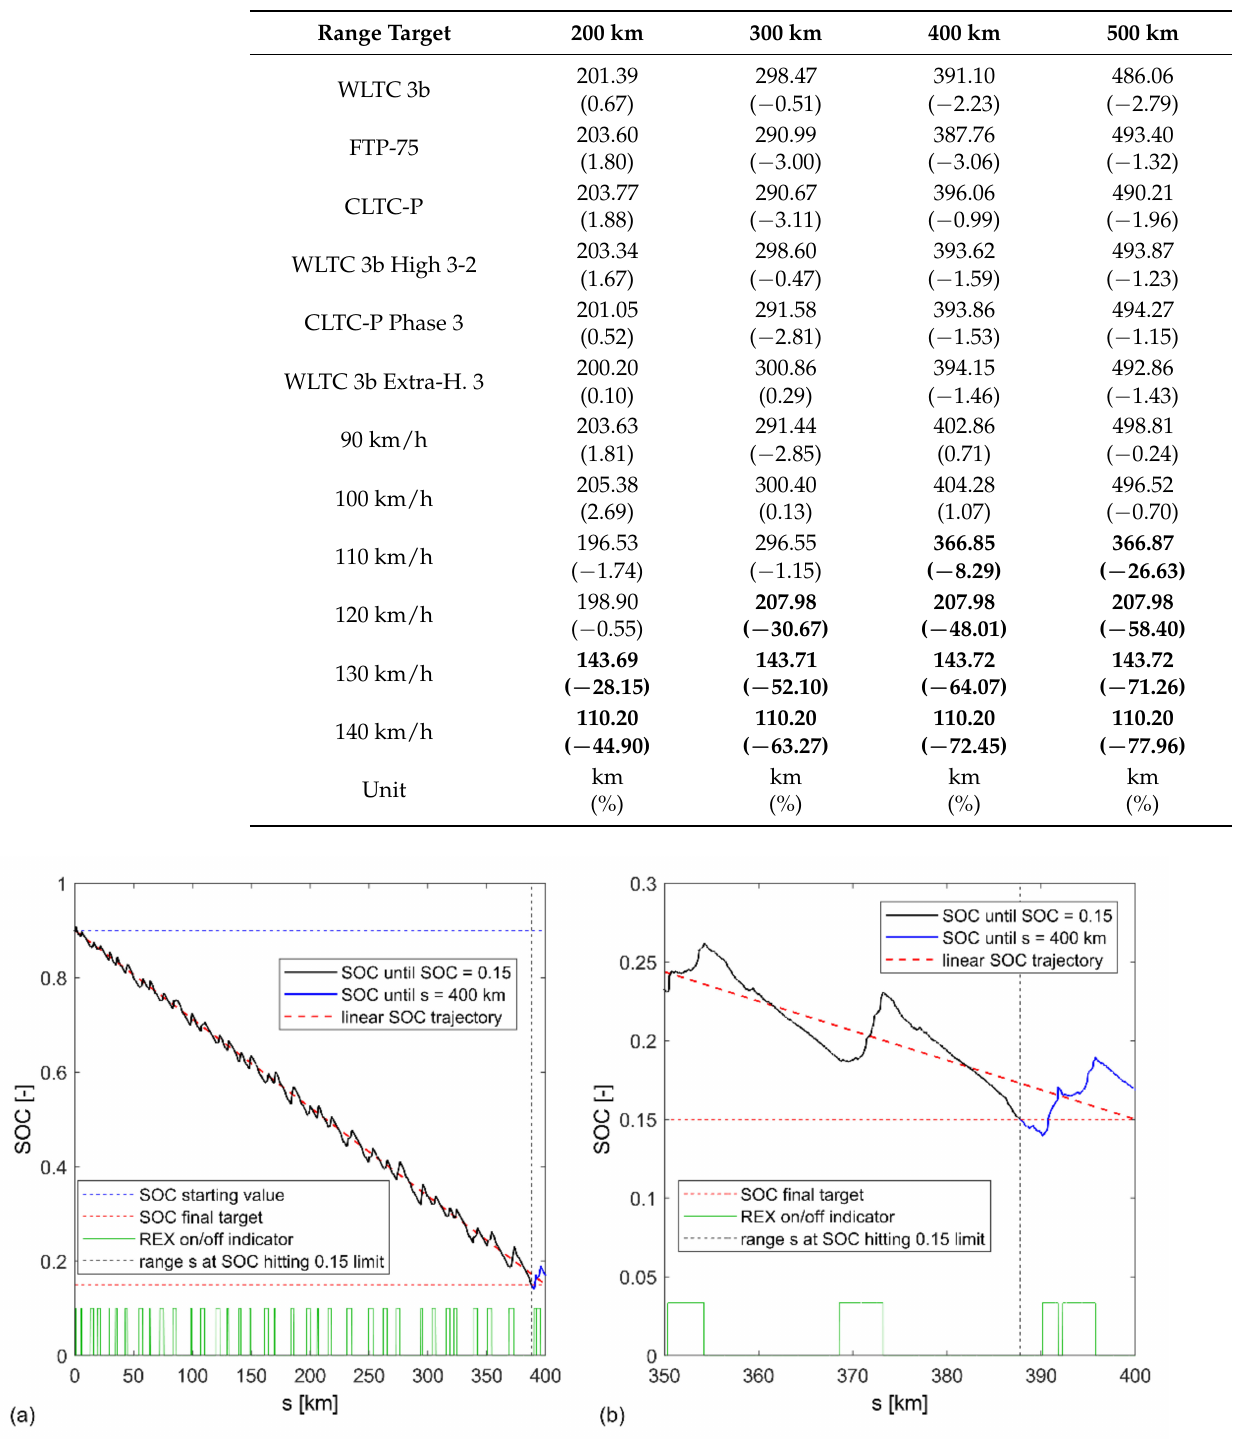
Table 13. Difference between range target and traveled range at 15% SOC. Bolded values indicate cases when the range target cannot be obtained. The average percent difference (excluding data when range cannot be obtained) is − 0.51%, with a standard deviation of 1.70%.